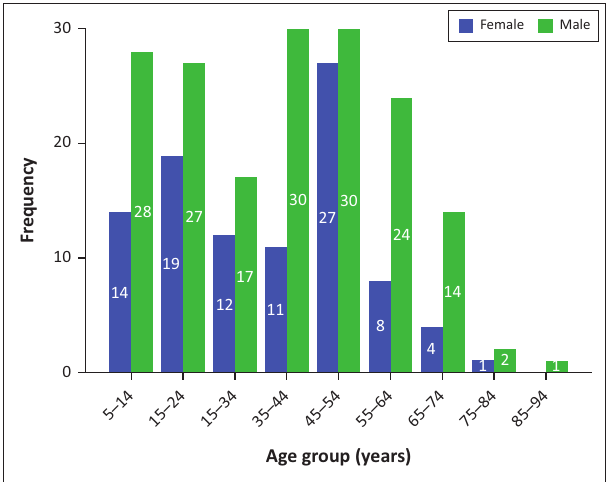
FIGURE 1: Age and sex distribution of